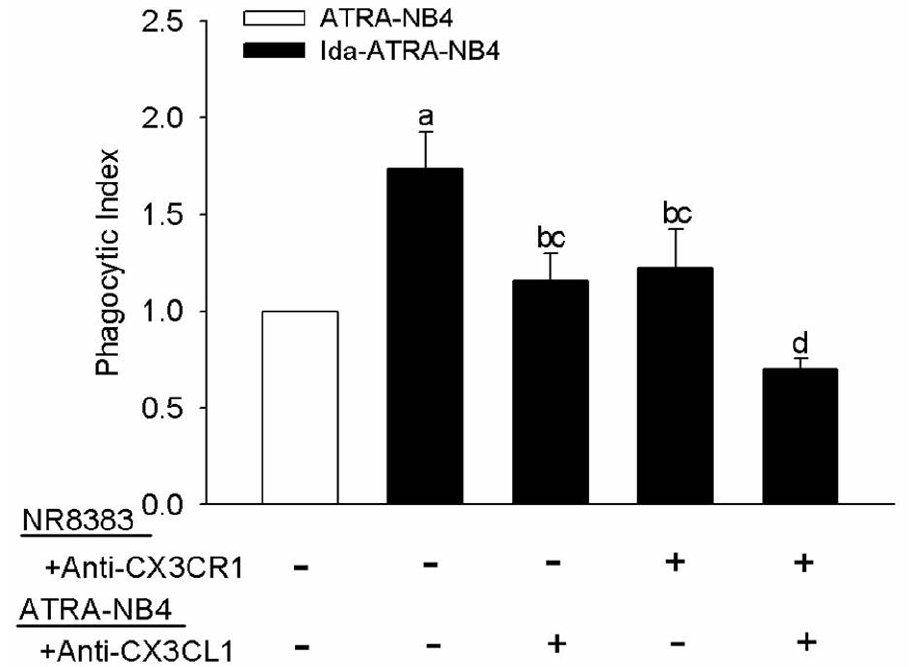
Figure 3. Surface CX3CL1 of apoptotic ATRA-NB4 cells enhances the phagocytic activity of NR8383 cells. NR8383 cells were treated with or without anti-CX3CR1 antibody before incubation with either living cells (blank bar) or apoptotic ATRA-NB4 cells (black bar) for the phagocytic assay. A subset of the Ida-ATRA-NB4 cells was pre-treated with anti-CX3CL1 antibody before incubation with NR8383 cells for the phagocytic assay. The results were expressed as a phagocytosis index, which indicates a fold increase relative to the phagocytic activity of Ida-untreated NR8383 cells (blank bar). The results are the means ± SD from four independent experiments a: p < 0.01 vs. blank bar; b: p < 0.05 vs. first left black bar; c: p < 0.05 vs. first right black bar; d: p < 0.001 vs. first left black bar.